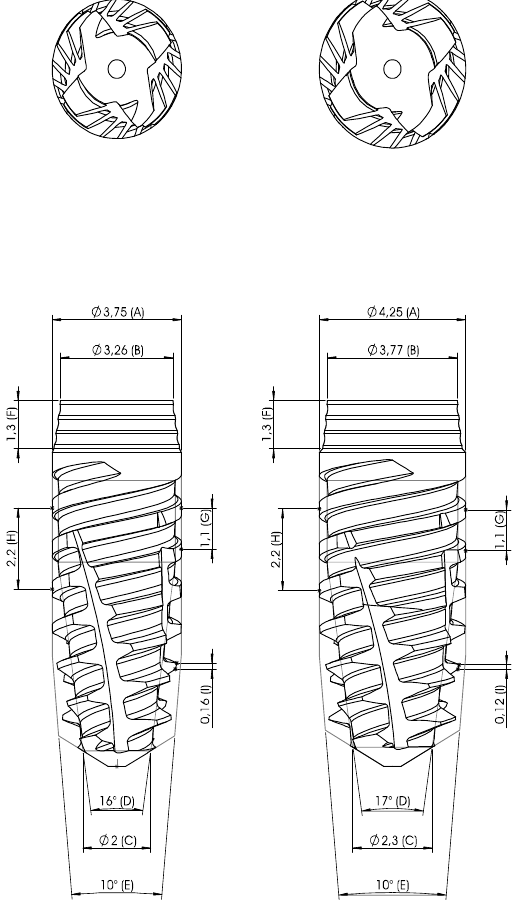
Figure 4. Prototype VII with two diameters.